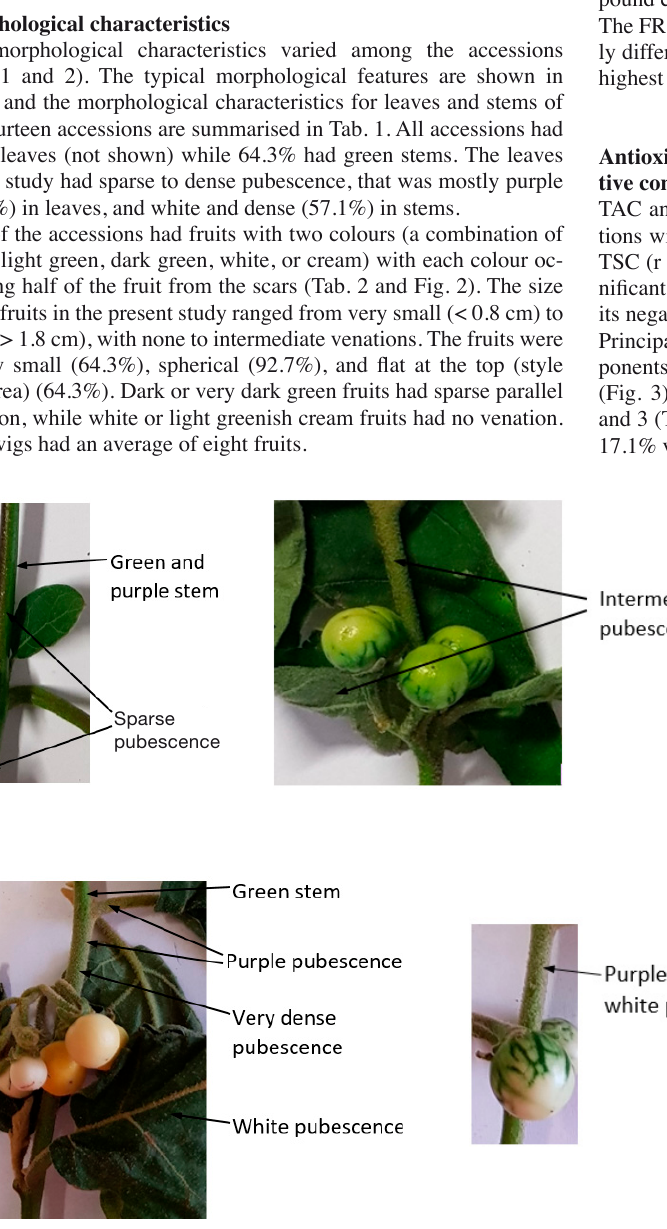
Fig. 1: Photographs of morphological characteristics of the leaves and stems of the Solanum anguivi Lam. accessions showing variation in pubescence density − sparse (A), intermediate (B), dense (C) and very dense (D); pubescence colour − purple (D), white (D) and purple and white (E); and stem colour − green (D), and green and purple